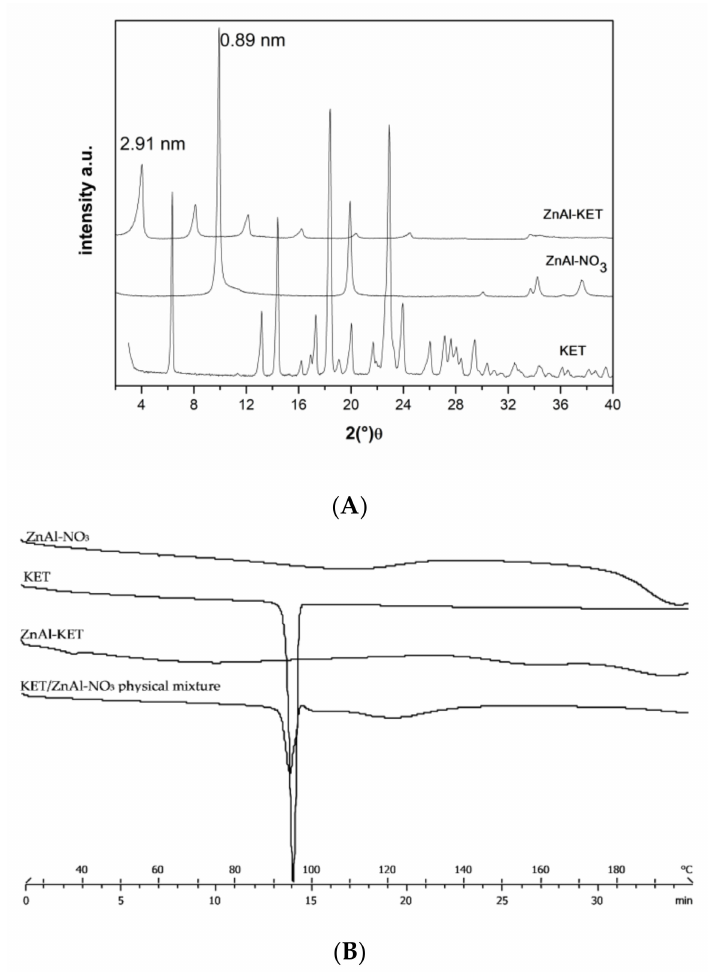
Figure 1. ( A ) XRPD pattern (X-ray di ff raction patterns) of crystalline ketoprofen (KET) (acid form), pristine ZnAl-NO 3 , and the hybrid ZnAl-KET. ( B ) Thermal profiles measured by di ff erential scanning calorimetry of ZnAl-NO 3 , crystalline KET, ZnAl-KET, and KET / ZnAl-NO 3 physical